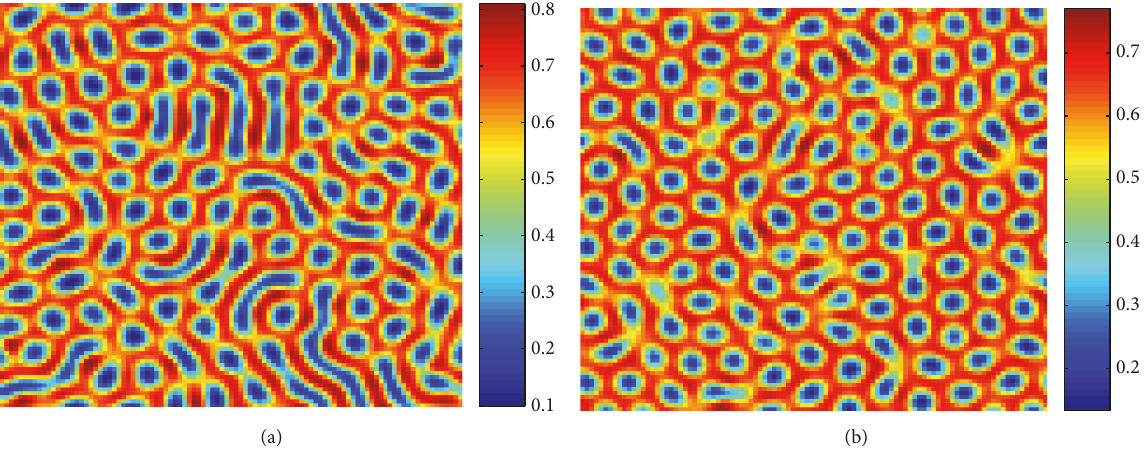
Figure 8: Two gapped vegetation patterns for the system. (a) 𝐴 = 1.68 × 10 −3 ; (b) 𝐴 = 1.70 × 10 −3 . 𝑇